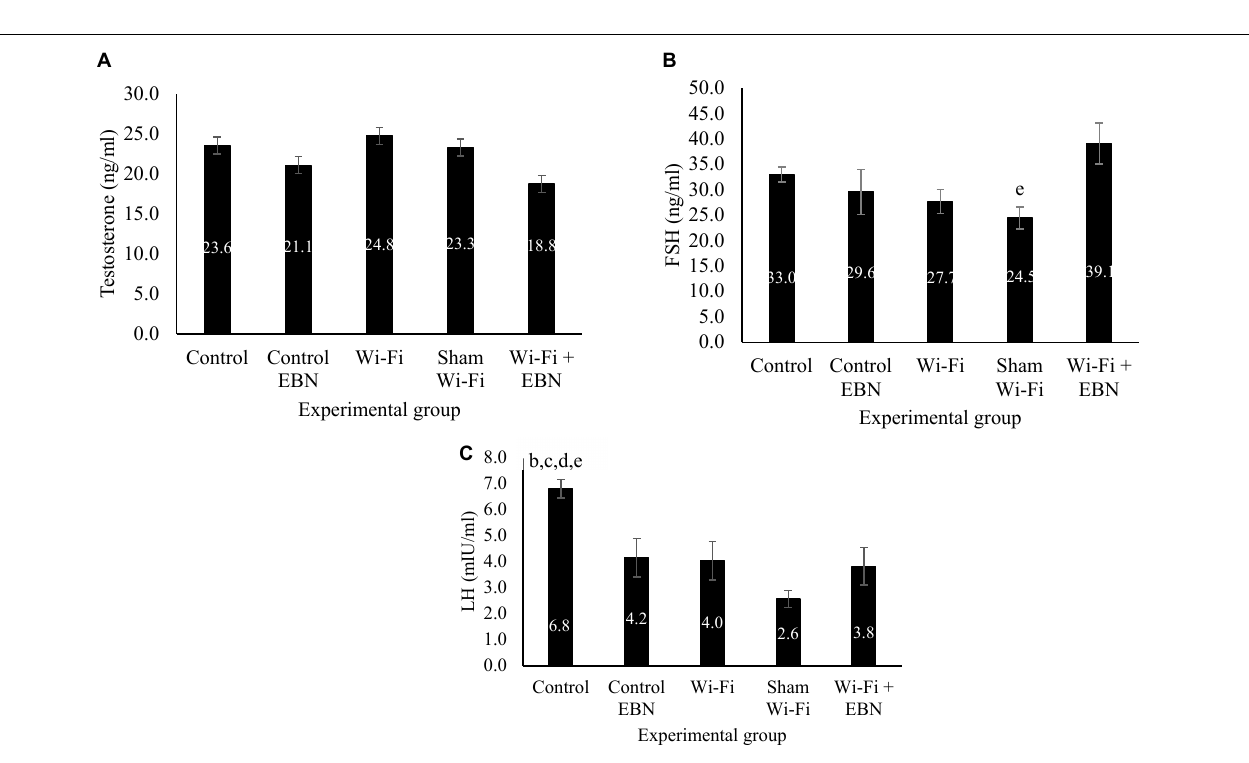
Frontiers in Physiology |